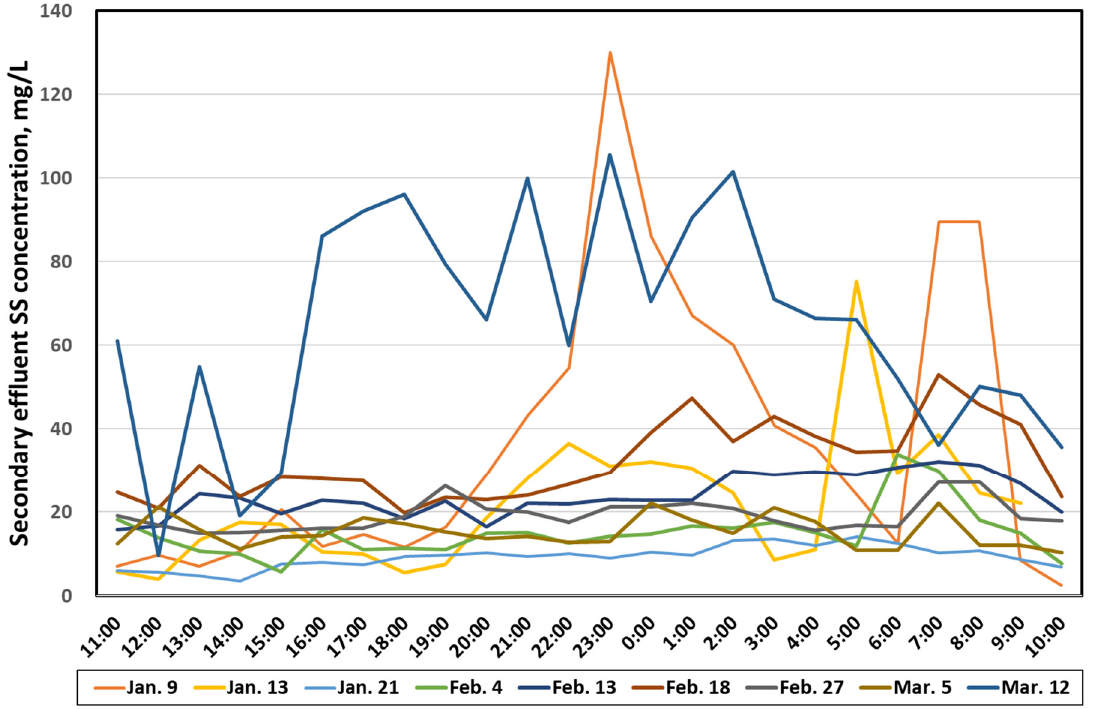
Figure 3. Diurnal variation of secondary effluent SS concentrations at the secondary clarifier at plant A during the sampling period.